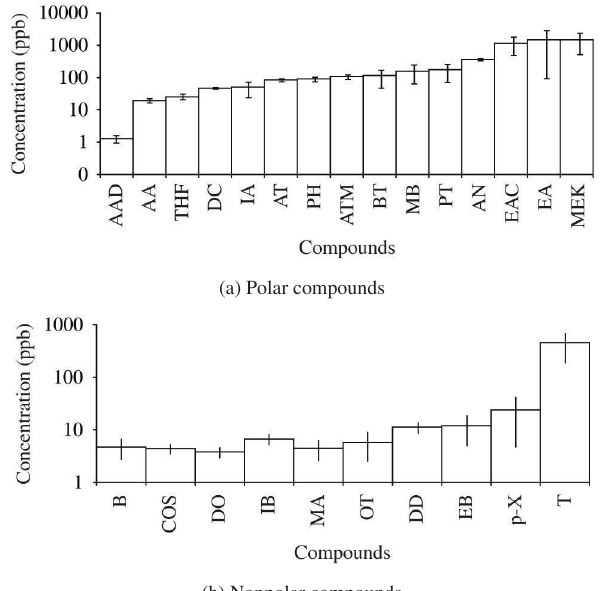
FIGURE 1: Comparison of the mean VOCs levels found in used Tedlar bags (refer to Table 1 for acronyms of the compounds.)